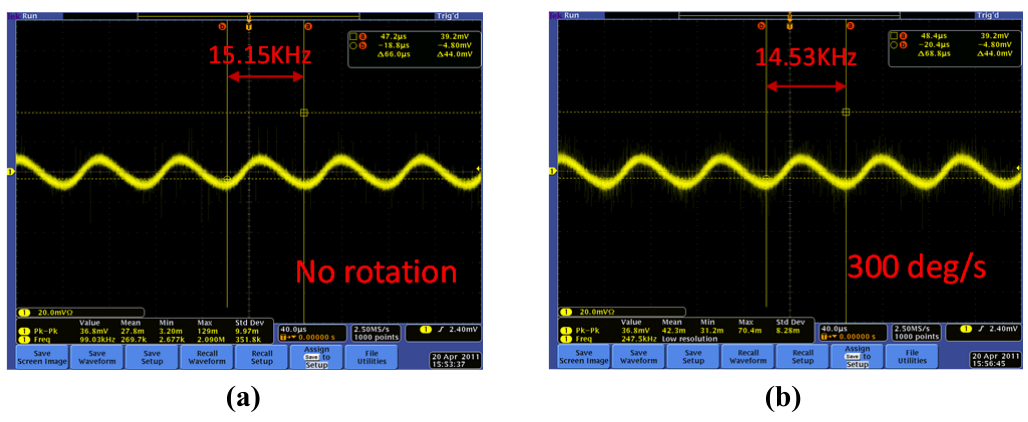
Figure 7. SAW gyroscope signal output depending on the different rotations (a) under no rotation and (b) under 300 deg/s rotation input.